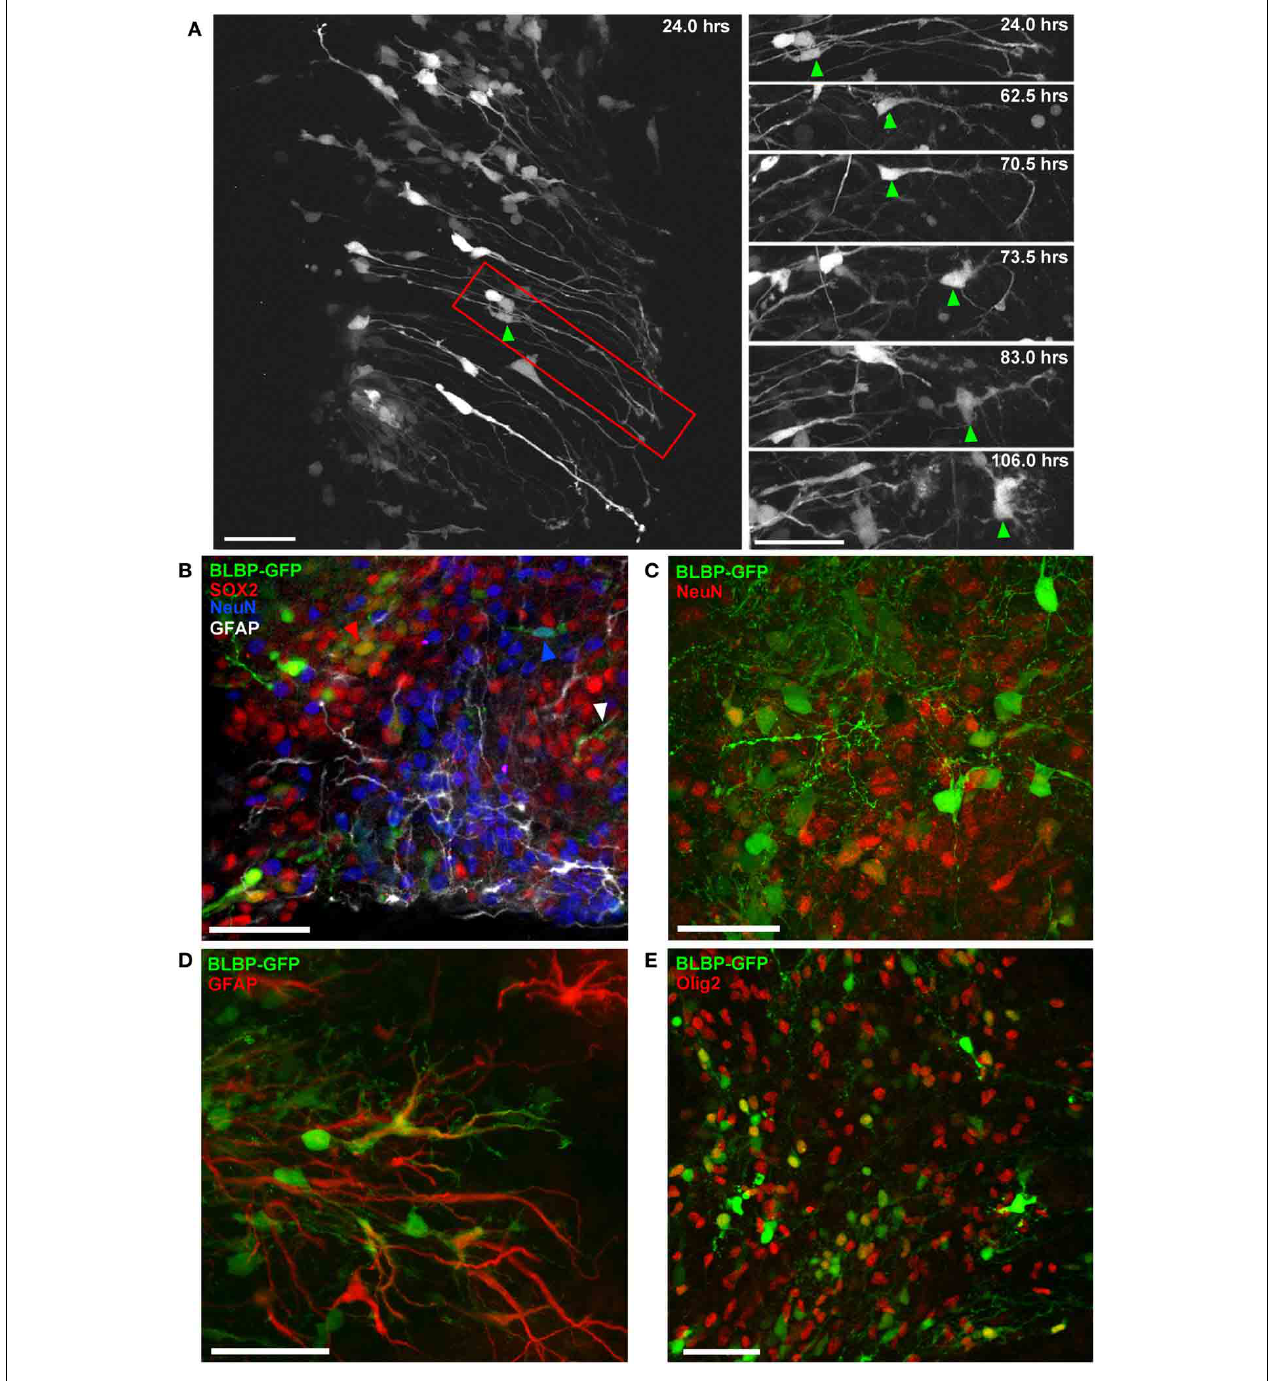
FIGURE 4 | Differentiation of BLBP-GFP expressing cells in spinal cord organotypic slice cultures. (A) Two-photon time-lapse sequence showing population of GFP-expressing cells (left panel) 24h after electroporation at E12. Region outlined in red is shown in selected time-lapse frames on the right. The cell indicated by the green arrow initially displays a radial morphology. Morphological changes occur over an 82h time period, after which the cell has acquired a multipolar morphology. (B–E) Using confocal microscopy and immunohistochemistry the contribution of BLBP-expressing cells to the generation of different neural cell lineages can be examined in